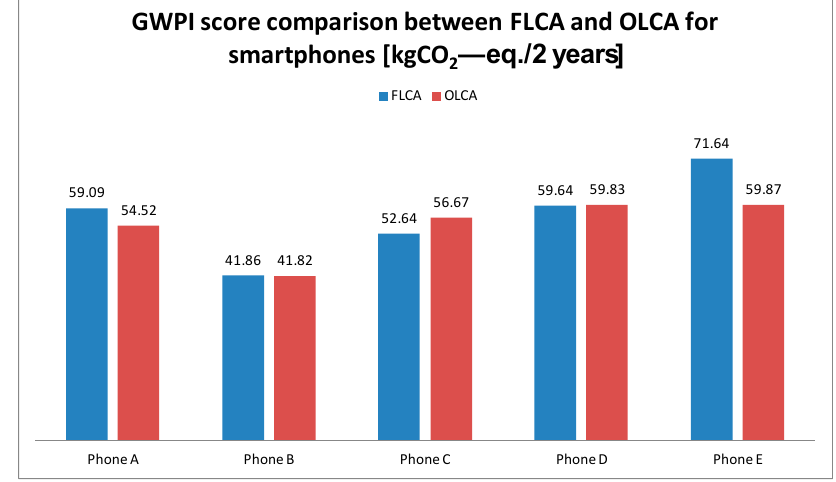
Figure 7. GWPI scores for FLCA of Phones A–E compared to OLCA.